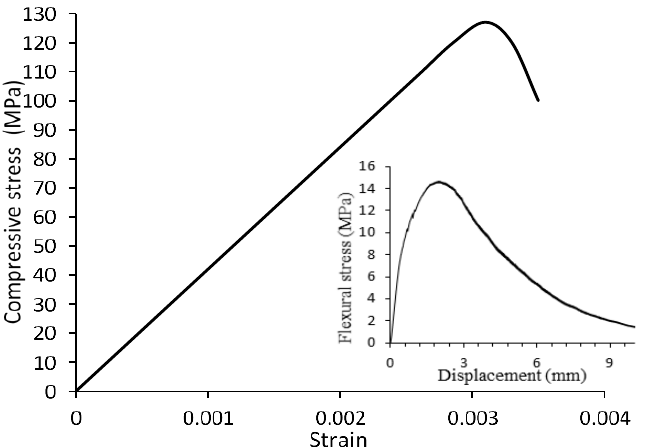
Figure 3. Typical compressive stress-strain and flexural stress-displacement responses of UHSC.